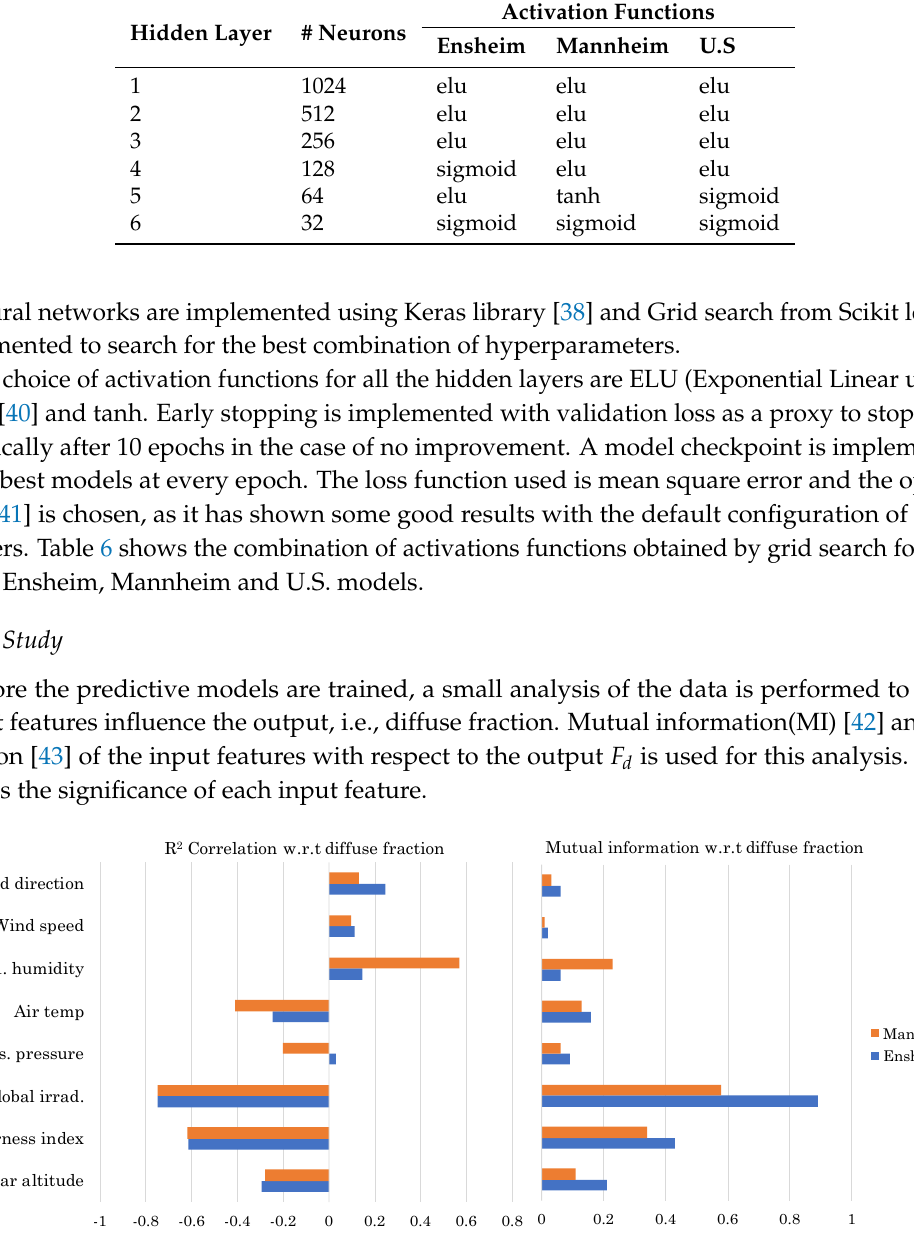
Figure 1. Mutual information and R 2 correlation coefficients of input features with respect to output F d for both